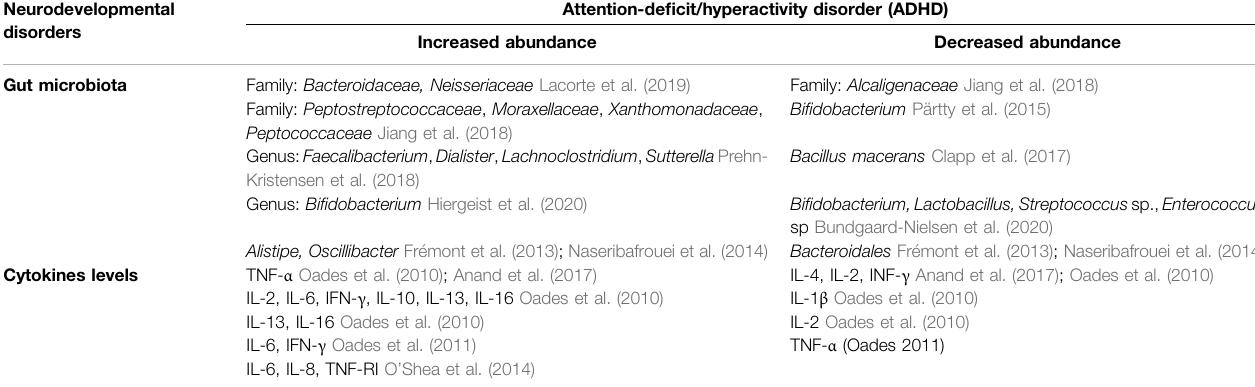
TABLE 2 | Gut microbes and level of cytokines in attention-de fi cit/hyperactivity disorder (ADHD). Neurodevelopmental